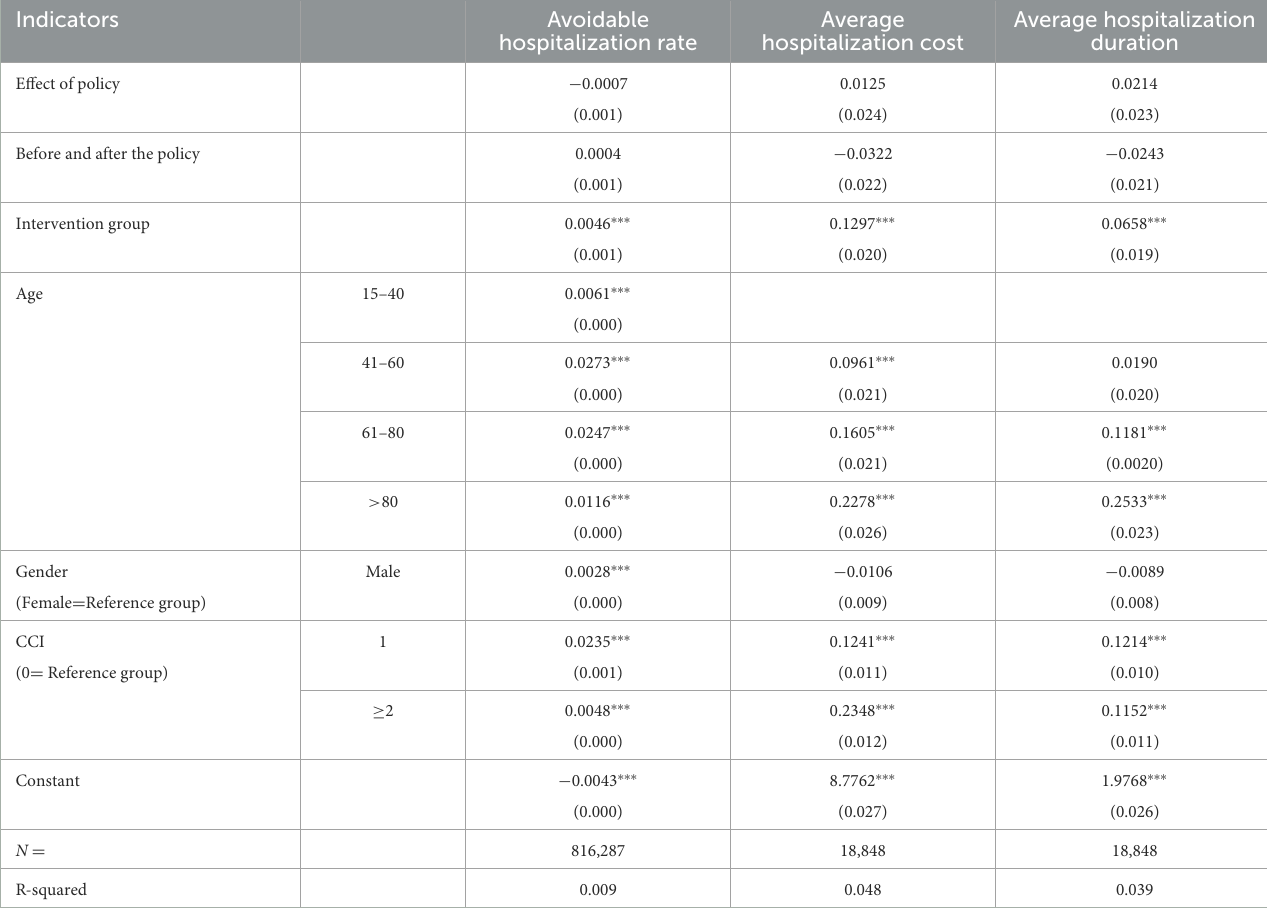
TABLE 4 Parallel trends test before policy change (DID model).